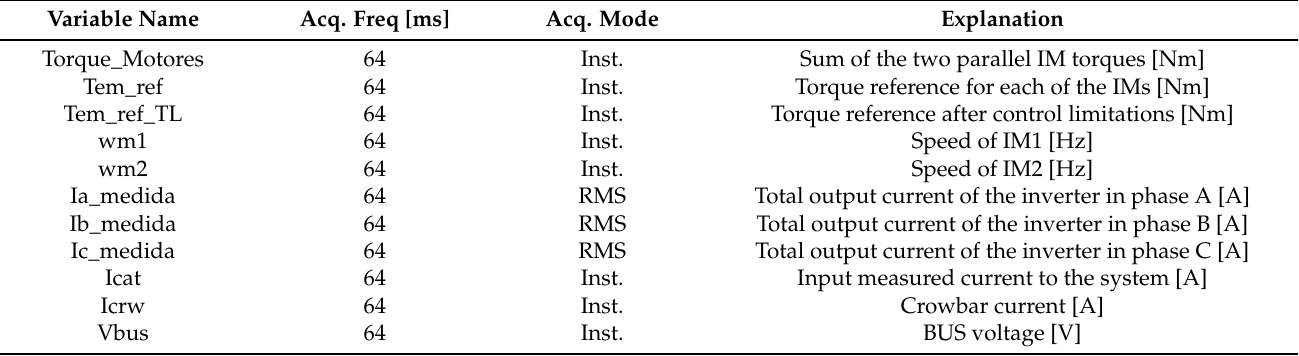
Table 2. Recorded variables from the SiL simulation platform.